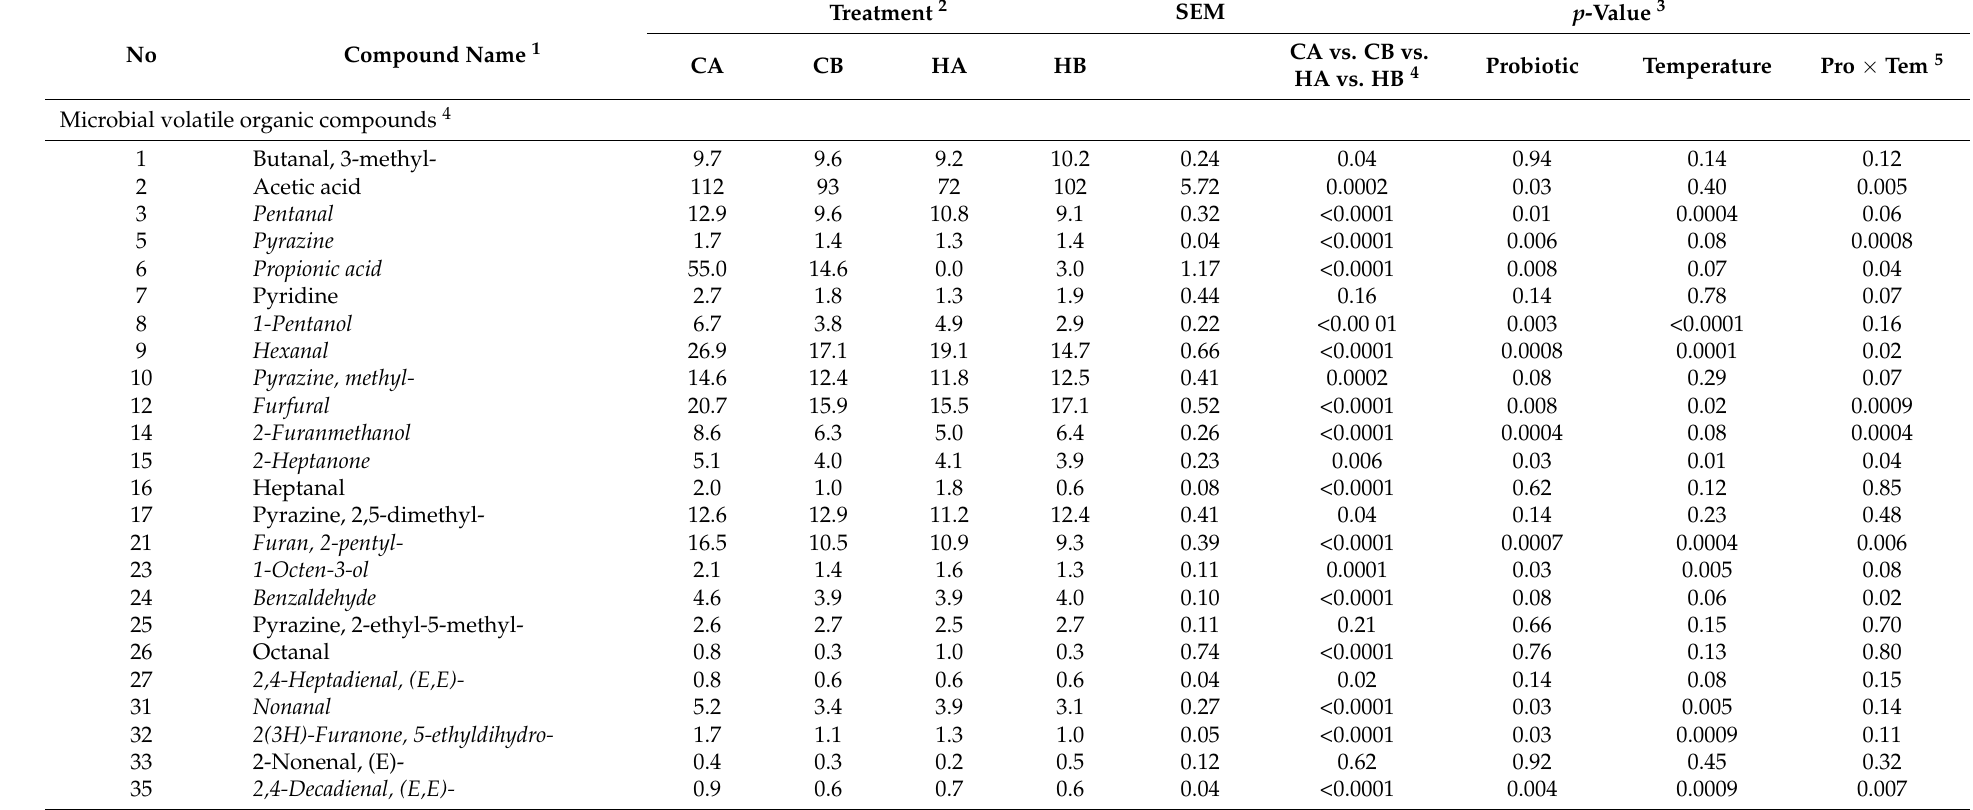
Table 2. Volatile organic compounds, listed in order of retention time, of the pelleted treatments measured by the Gas chromatography/Mass